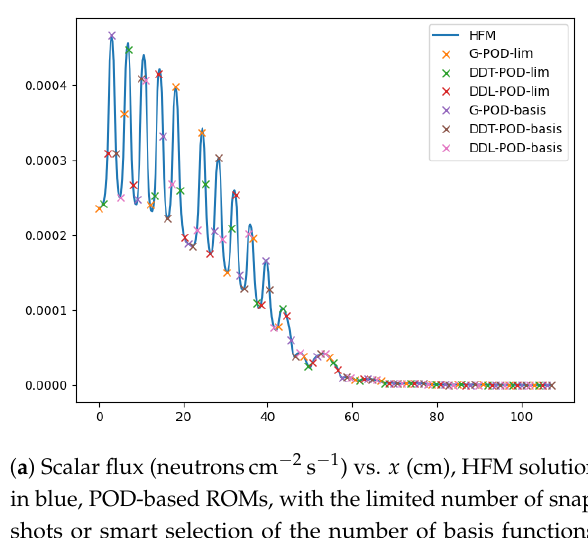
Figure 15. Scalar flux for Energy Group 1 for the HFM (blue) and POD-based ROMs, with the limited number of snapshots or smart selection of the number of basis functions, in crosses, and the pointwise error between them with parameters R 1 = 2, R 2 = 2, R 3 = 1, R 4 = 1, R 5 = 4.